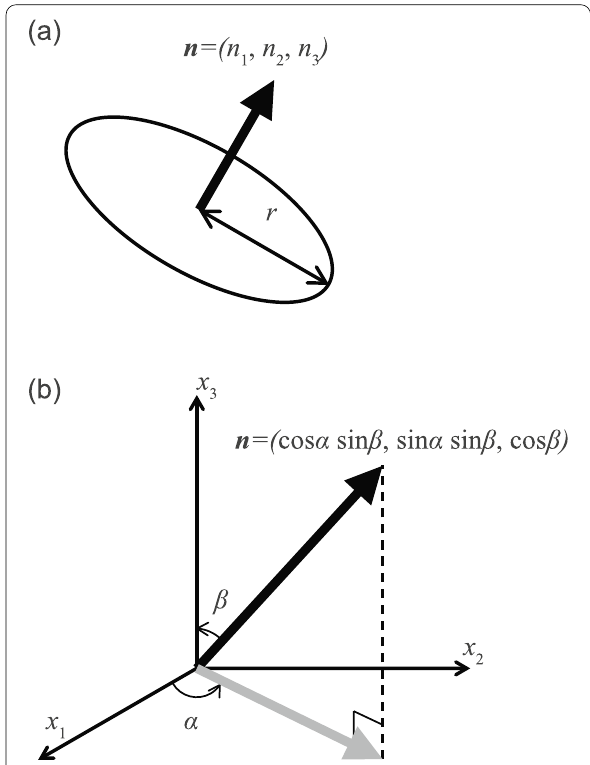
Fig. 1 a Geometric definition of the normal unit vector, n , of a fracture (or vein) approximated as a disk-shape with a radius, r .